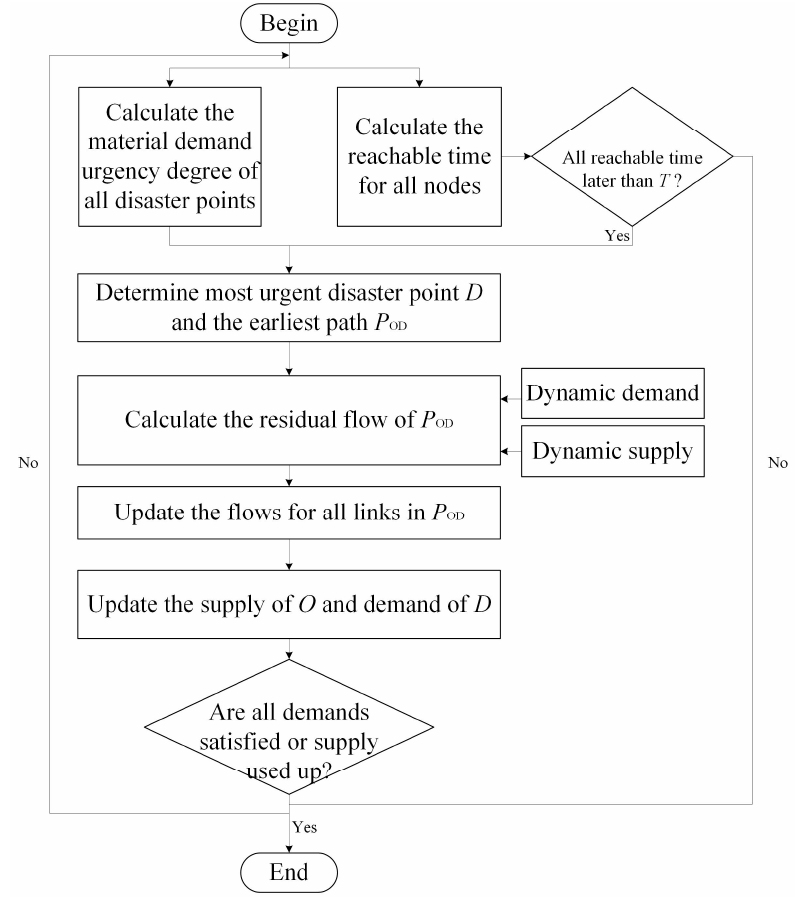
Figure 4. The flowchart of the solving method.